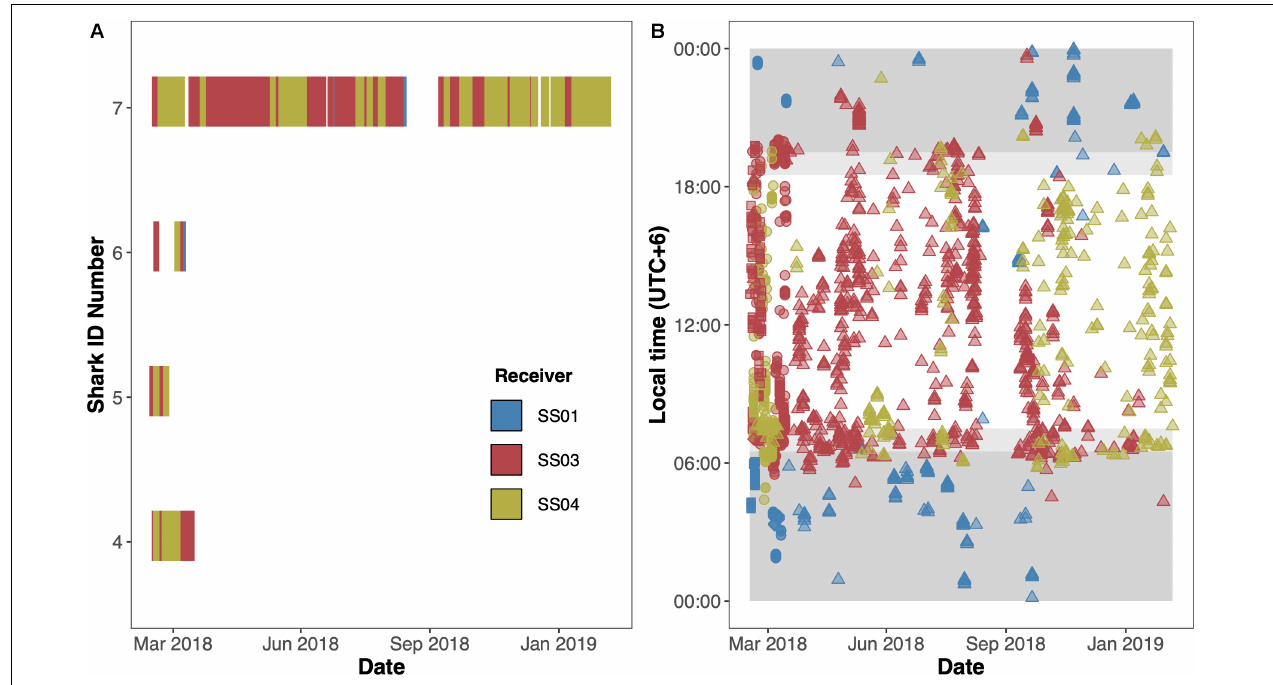
FIGURE 3 | Acoustic detections of four silky sharks ( Carcharhinus falciformis ) at the Sandes-Swart seamount complex in the Chagos Archipelago in March 2018. (A) Detections over time for all four individuals. (B) Diel detections for individuals (circle = Shark 4, square = Shark 5, diamond = Shark 6, and triangles = Shark 7) across the full time series. Dark gray shaded areas represent night-time (19:30–06:30), and lighter gray shaded areas represent dawn (06:30–07:30) and dusk (18:30–19:30). Colors represent the receivers the shark was detected on with blue = SS01; red = SS03; and yellow = SS04. TABLE 3 | Acoustic tag deployments on silky sharks ( Carcharhinus falciformis) around the Chagos Archipelago between 2013 and 2018. Shark ID V16 code Sex